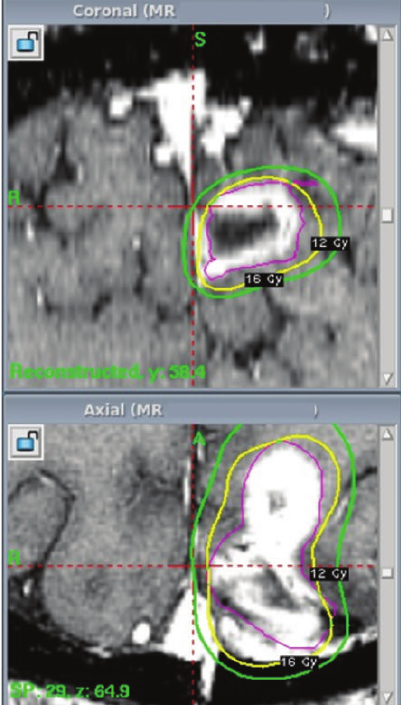
Figure 2: Four months after initial diagnosis, the patient suffered a recurrence of GBM and was treated with GKRS. The prescribed dose was 16Gy to the 50% isodose line. Tumor volume was measured at 5.2 cubic centimeters.